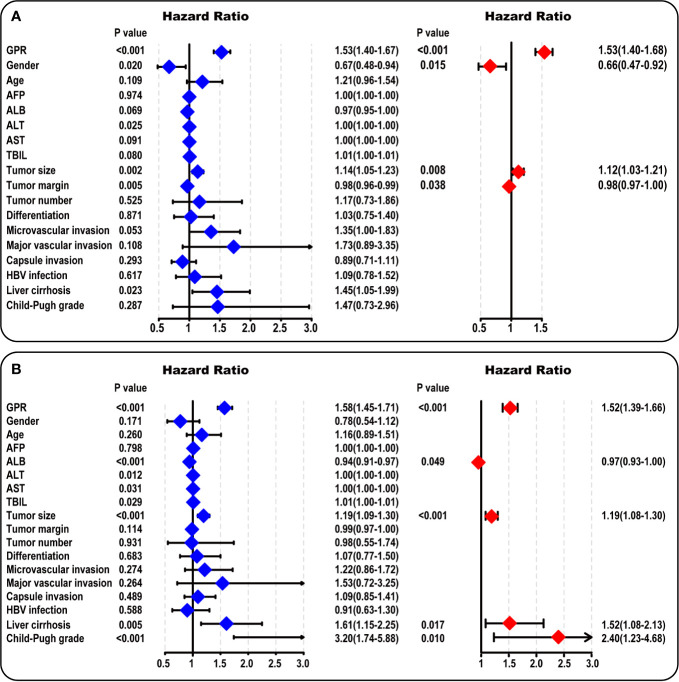
Univariate and multivariate analysis in the training cohort. (A) The forest map results of the univariate and multivariate survival analysis of DFS among HCC patients are shown. (B) The forest map results of the univariate and multivariate survival analysis of OS among HCC patients are shown. AFP, α-fetoprotein; ALB, albumin; ALT, alanine aminotransferase; AST, aspartate aminotransferase; TBIL, total bilirubin; HBV, hepatitis B virus; GPR, gamma‐glutamyl transpeptidase‐to‐platelet ratio; HCC, hepatocellular carcinoma.